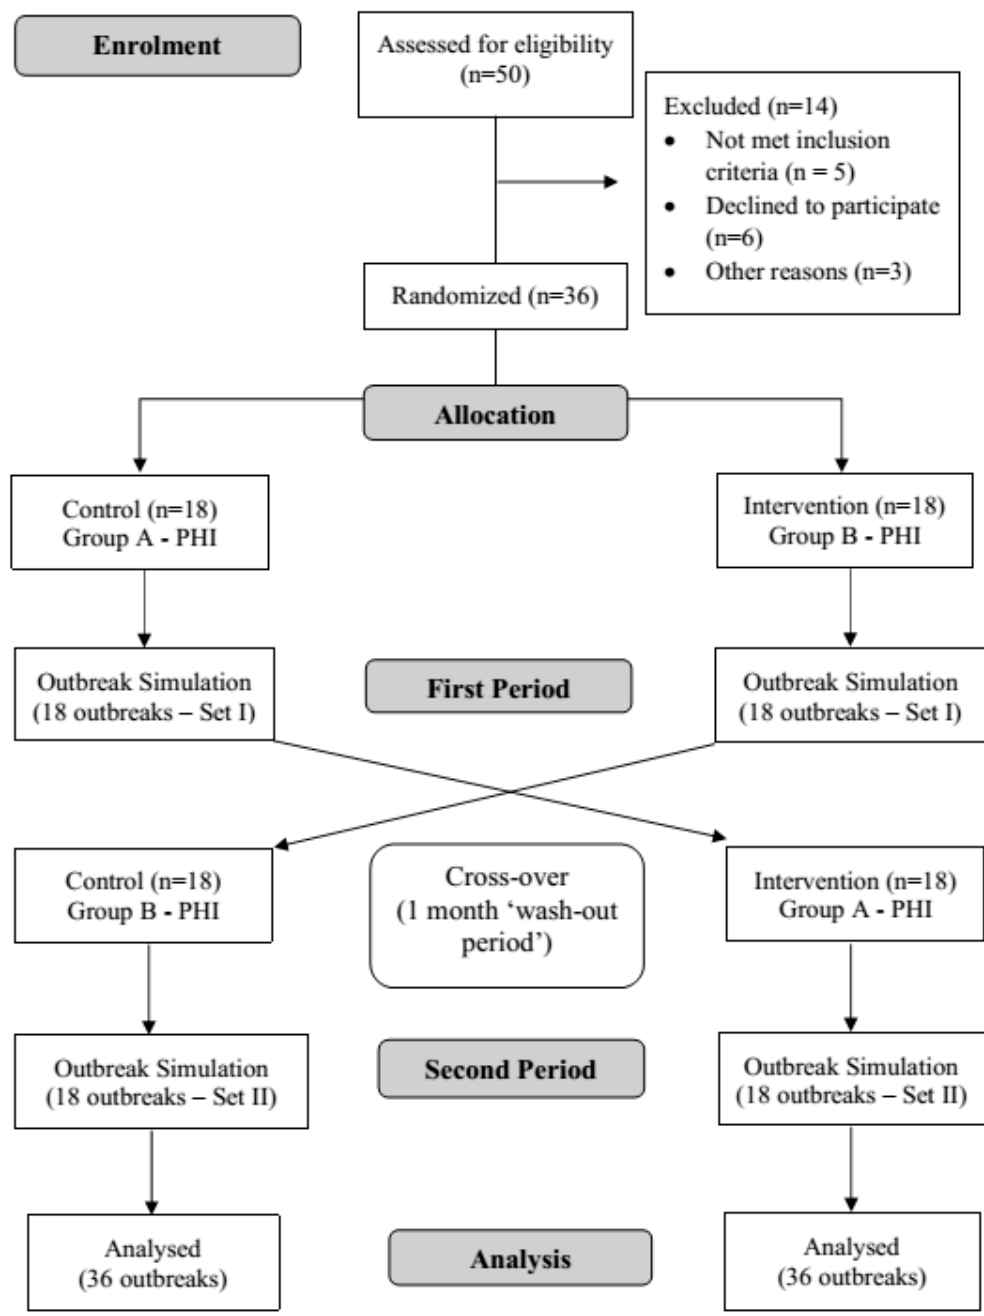
Figure 1. Flow chart of this study.